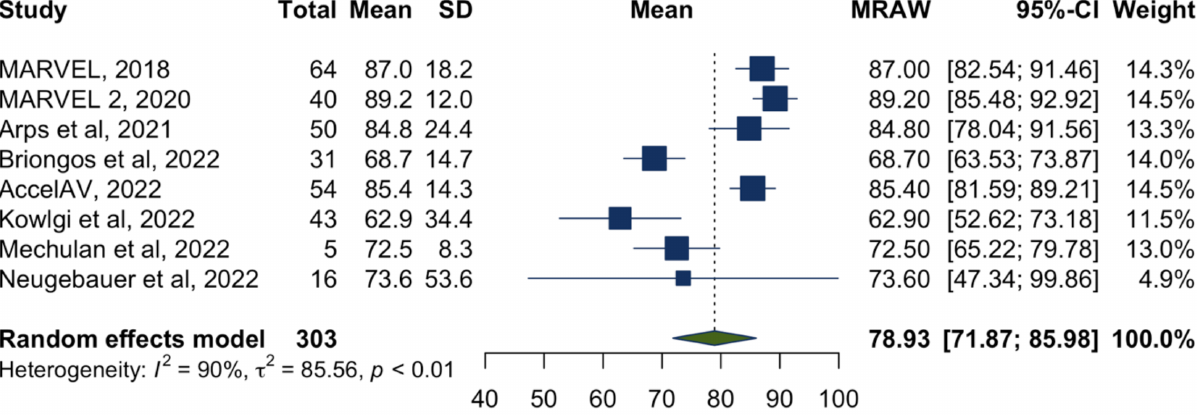
Figure 2. Forest plot of the atrioventricular synchrony proportion (%)